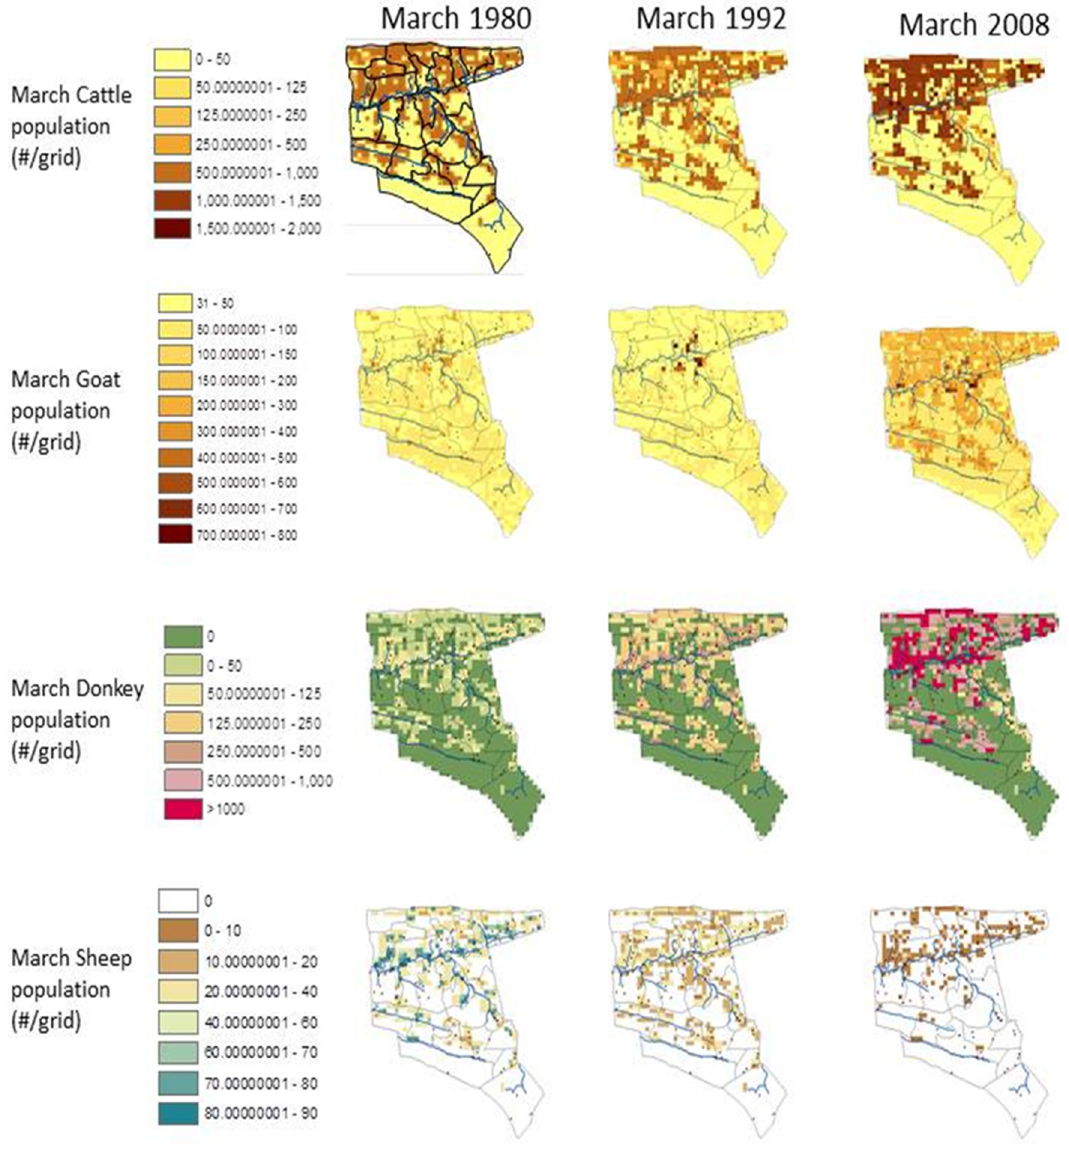
Figure 14. Spatial distribution of the livestock for selected years (March 1980, 1992 and 2008).